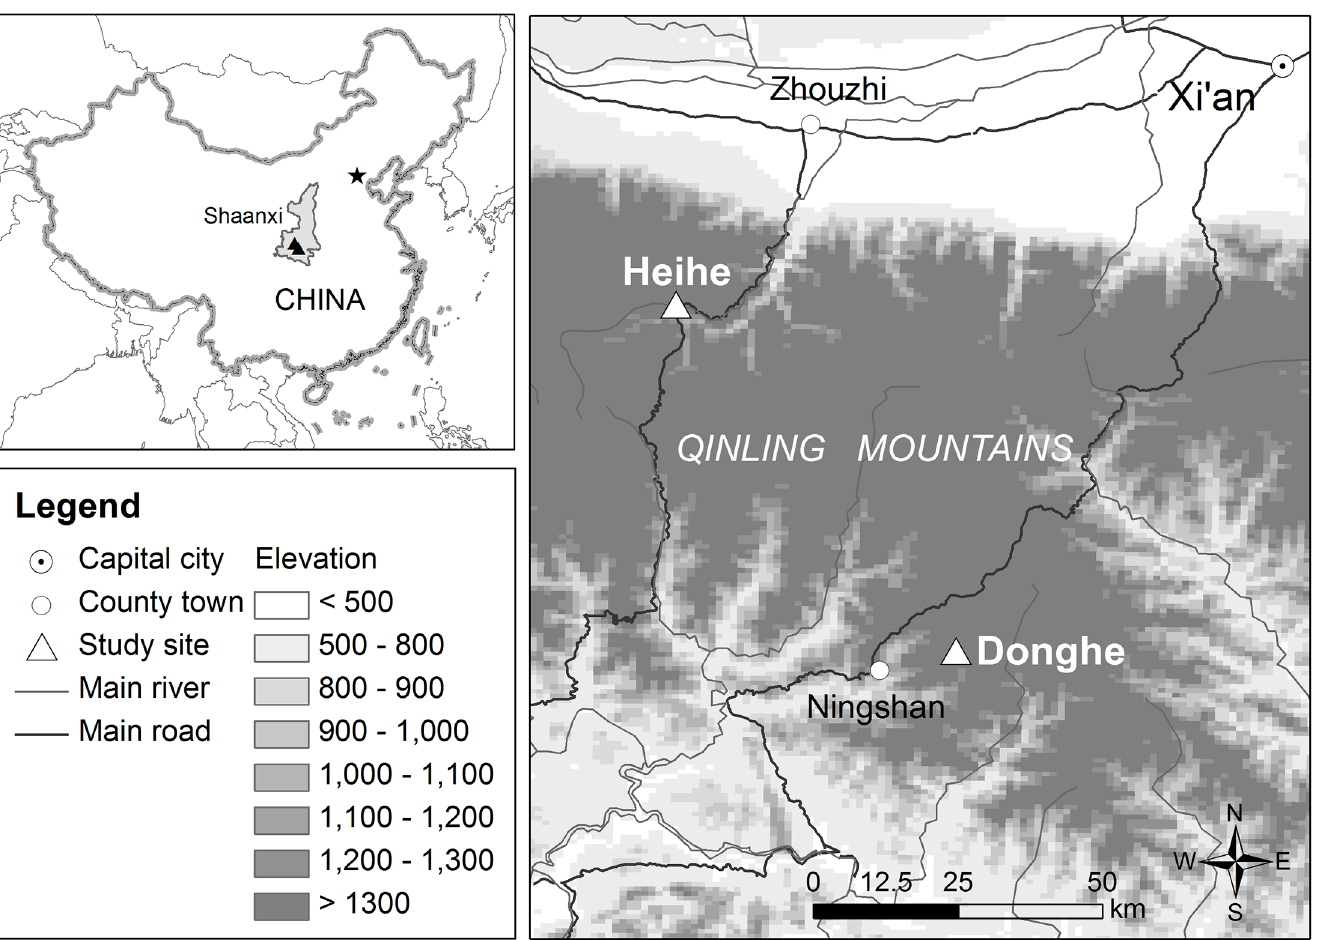
Fig 1. General location of the study sites. We reintroduced 31 juvenile Chinese giant salamanders in two rivers within the Qinling Mountains in central China. Details of reintroduction locations are not displayed so as to protect released animals from possible disturbance or